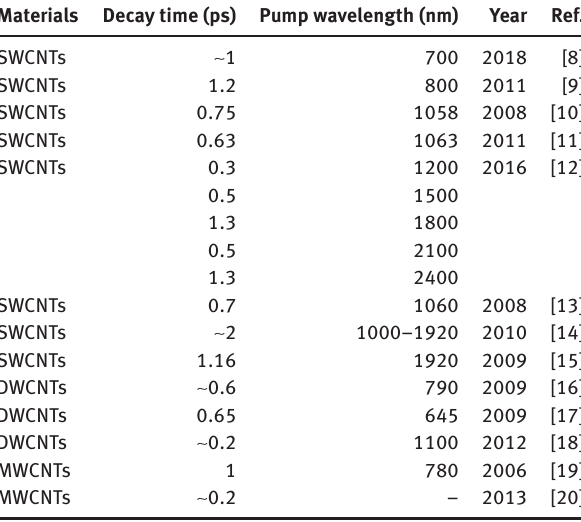
Table 1: Typical decay time of CNTs at different